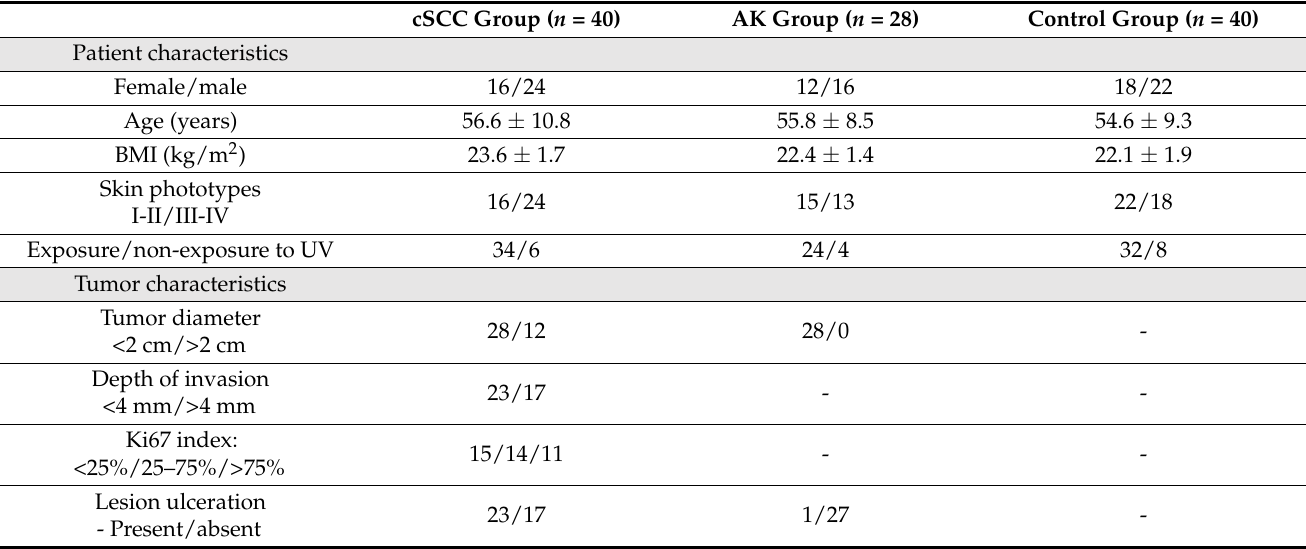
Table 1. Clinical data of the study participants and tumor